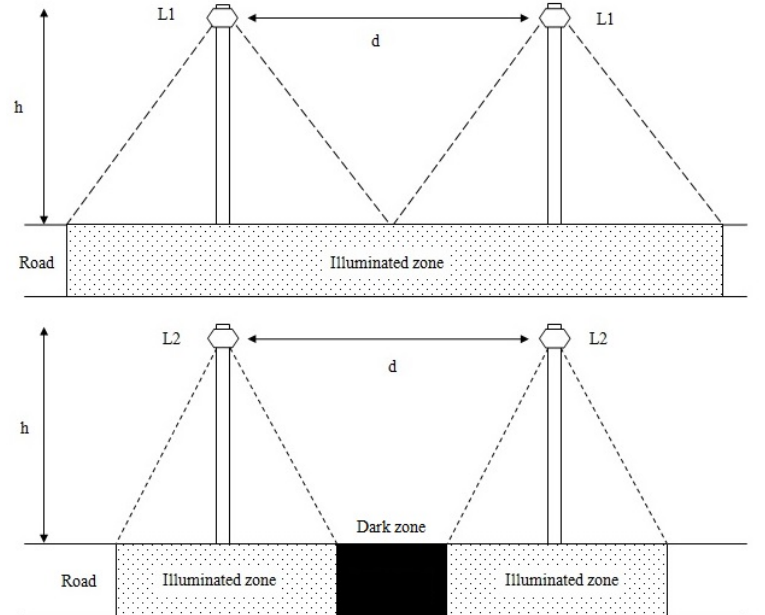
Figure 1. Deficient average uniformity resulting from an incorrect replacement of luminaries (model L1 to model L2) without rearrangement of the poles in one installation with height, h, and separation, d.